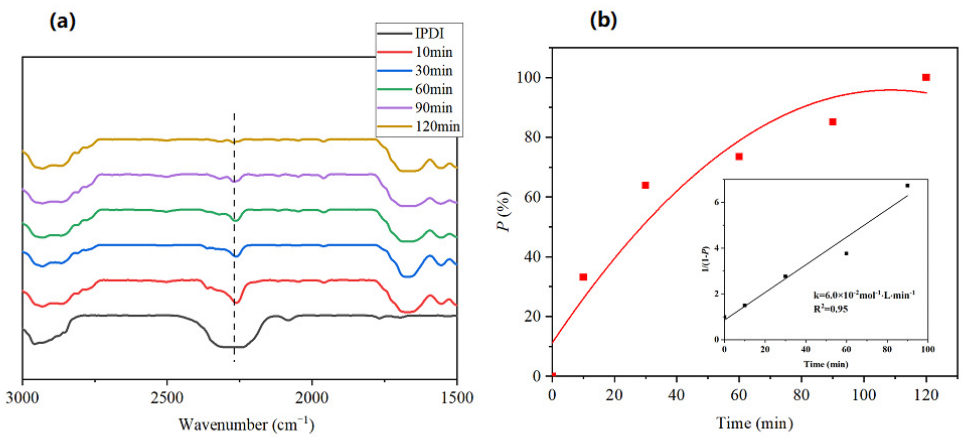
Figure 1. ( a ) The FTIR monitored kinetics of the model reaction of IPDI and DMU. ( b ) The evolution of the conversion degree of -NCO in polymerization ( p ) as a function of reaction time. The insert is the second-order kinetic fitting result of the reaction.